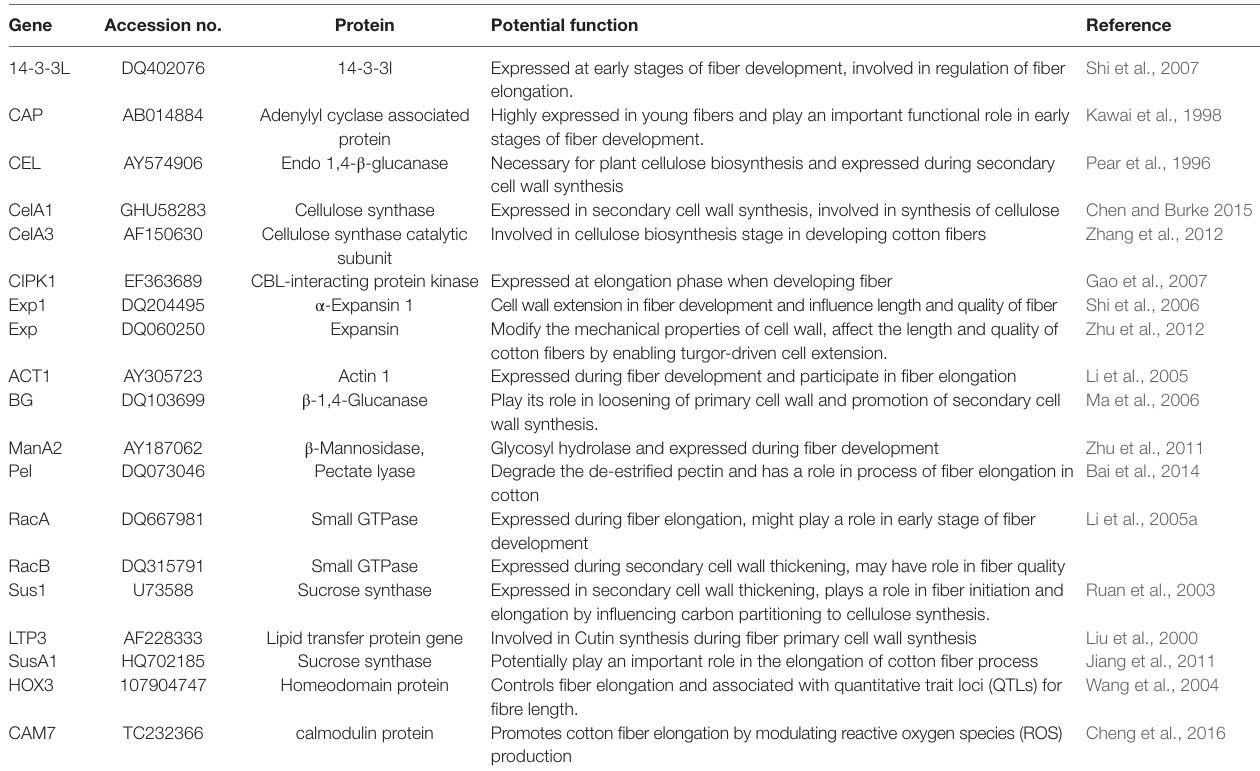
TABLe 1 | Some potential genes involved in cotton fiber